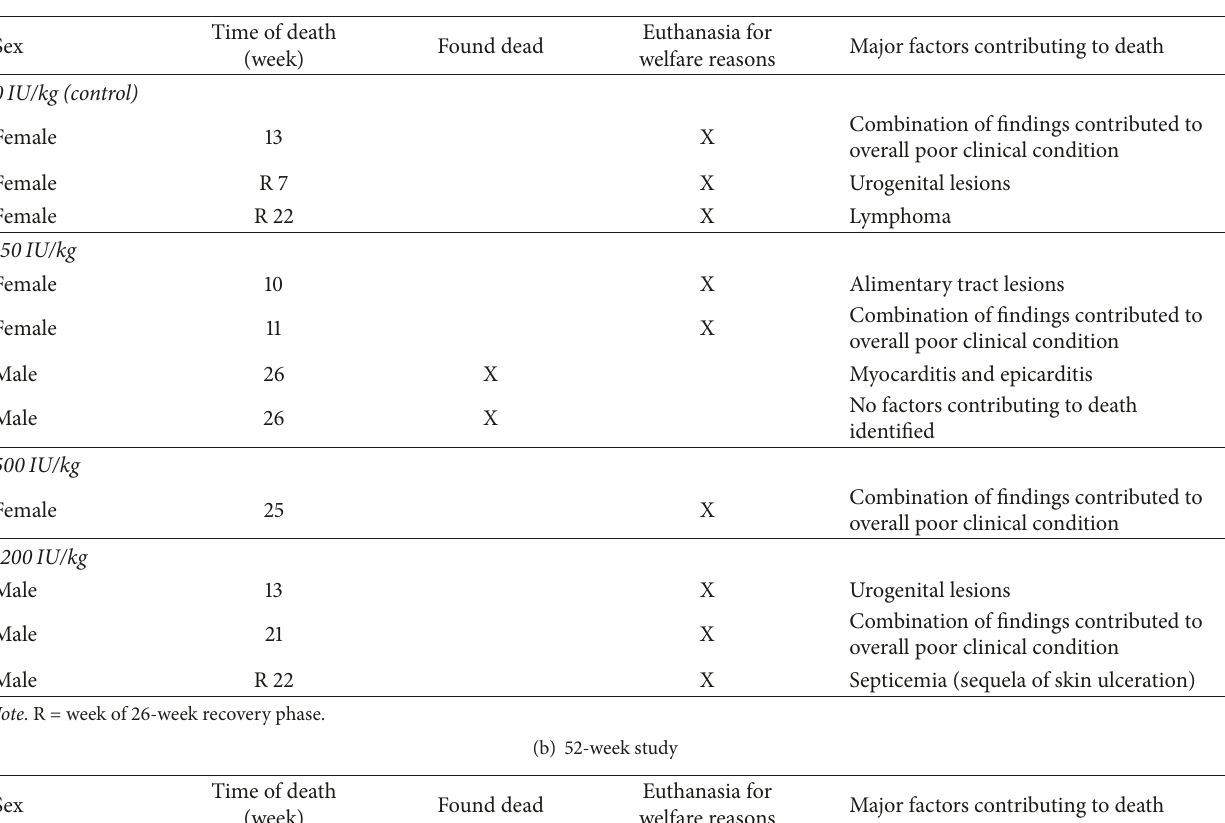
Table 4: List of unscheduled deaths and contributing